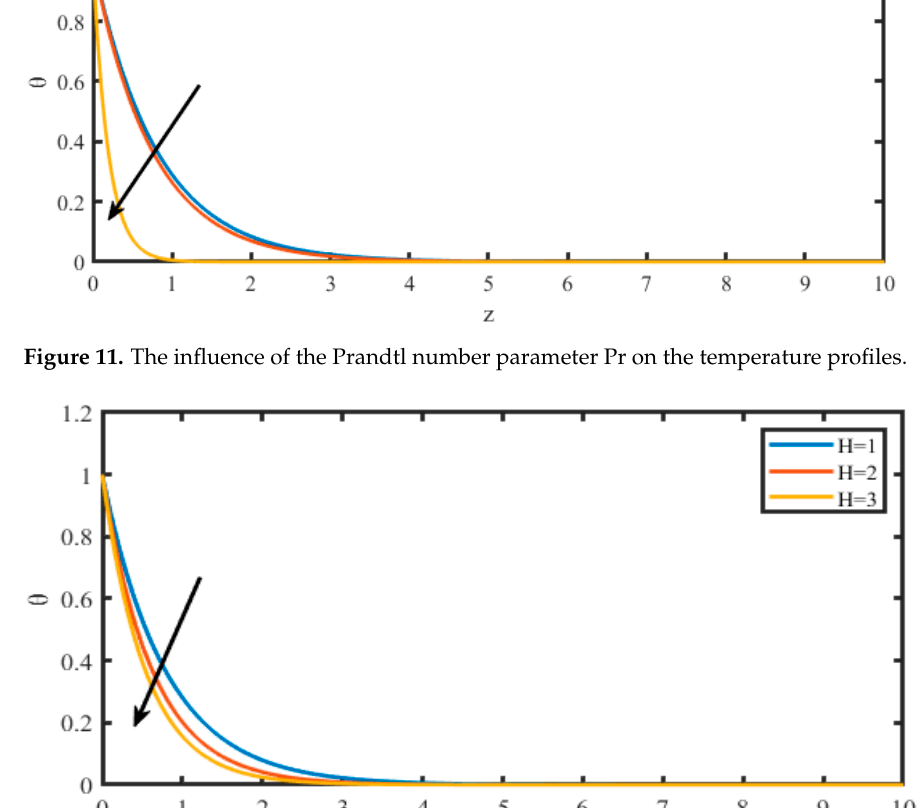
Figure 12. The influence of the Heat source parameter H on the temperature profiles.